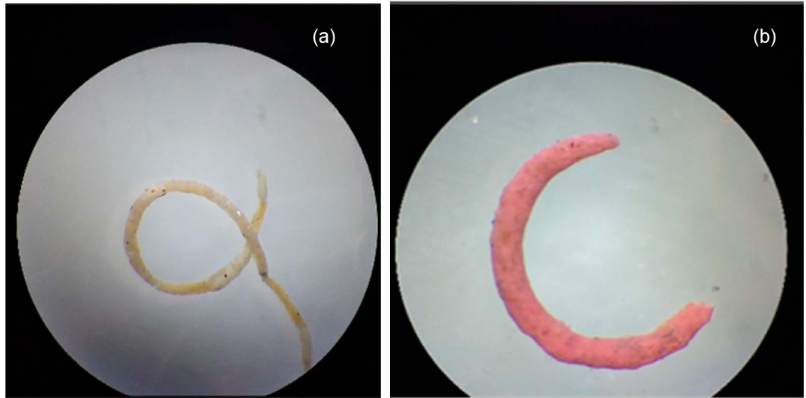
Figure 1. Microphotograph (40x magnification) of excrement of P. acuta in ( a ) Twisted rope shape, ( b )